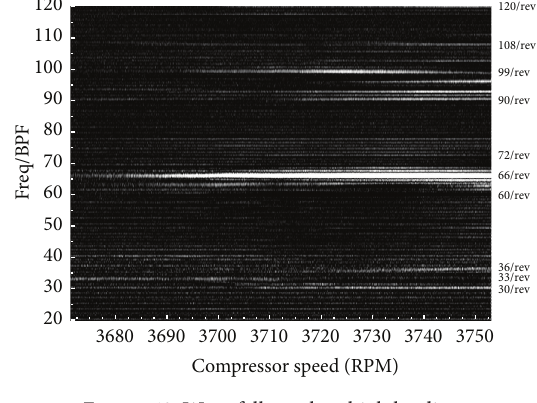
Figure 13: Waterfall graph at high loading.